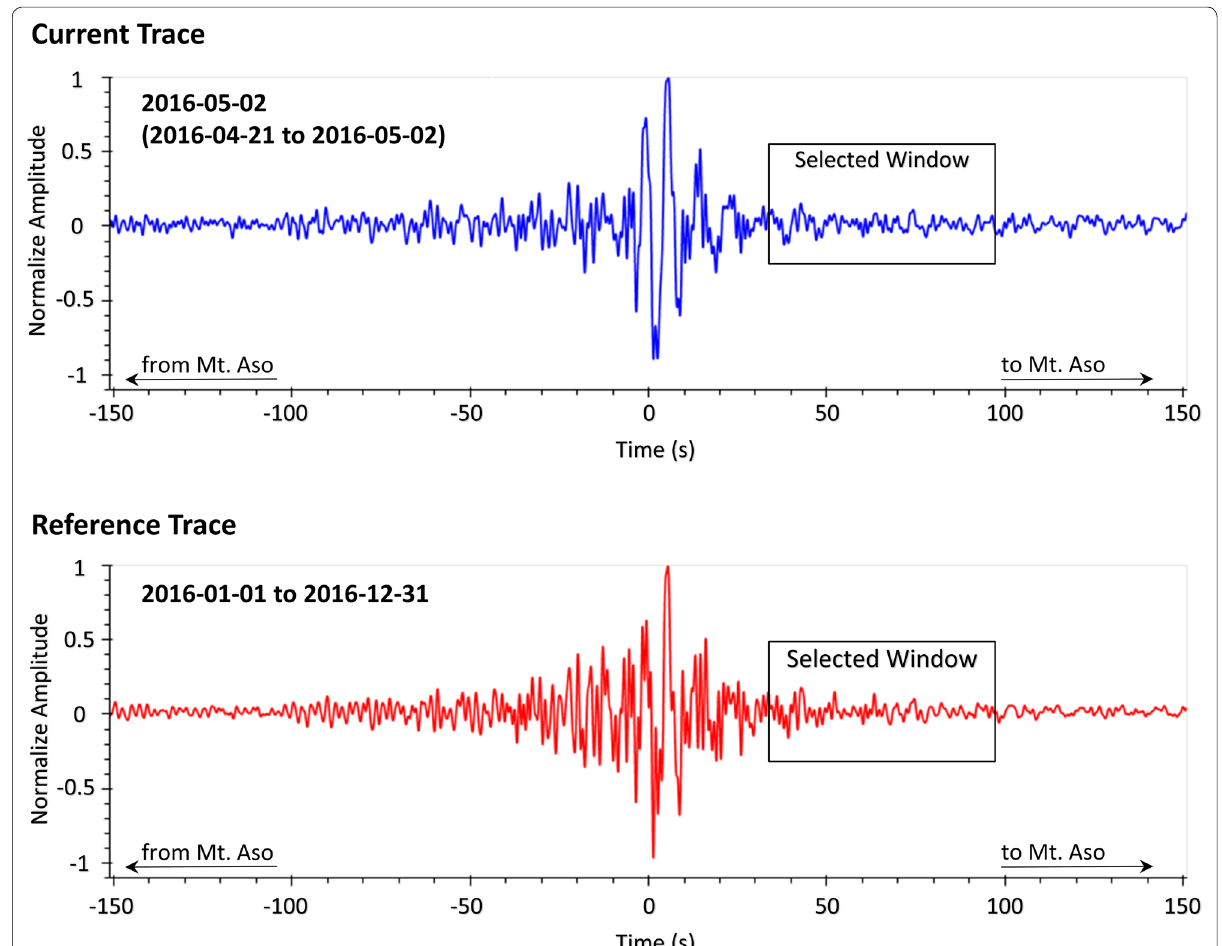
Fig. 2 Example of the current trace (blue) and the reference trace (red). The rectangles represent the time windows of the coda part of the seismograms, used to estimate seismic velocity changes by the stretching interpolation method. In order to reduce strong noise from Mt Aso, we use the trace side that the waveform propagates to Mt. Aso (positive